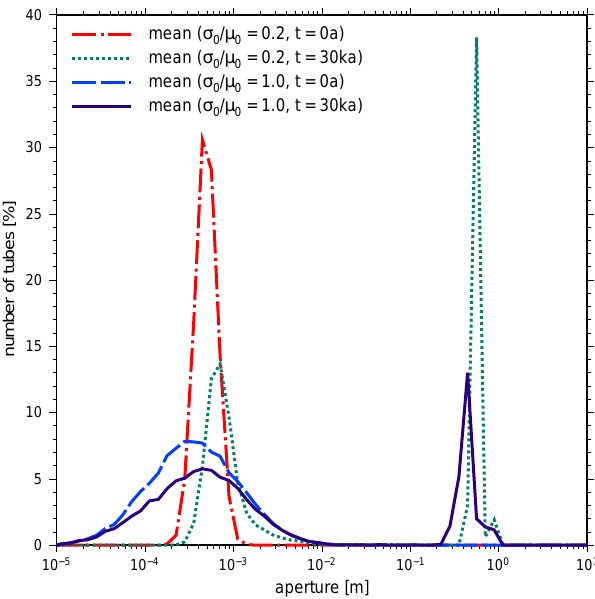
Fig. 3. Mean aperture distributions after 0a and 30ka of the models with total maximum recharge rates of Q max = 10 − 3 m 3 s − 1 . The mean is derived from 30 realisations for high and low degrees of protoconduit heterogeneity, respectively. At mature stages, protoconduit heterogeneity does affect the number of strongly enlarged tubes but hardly their